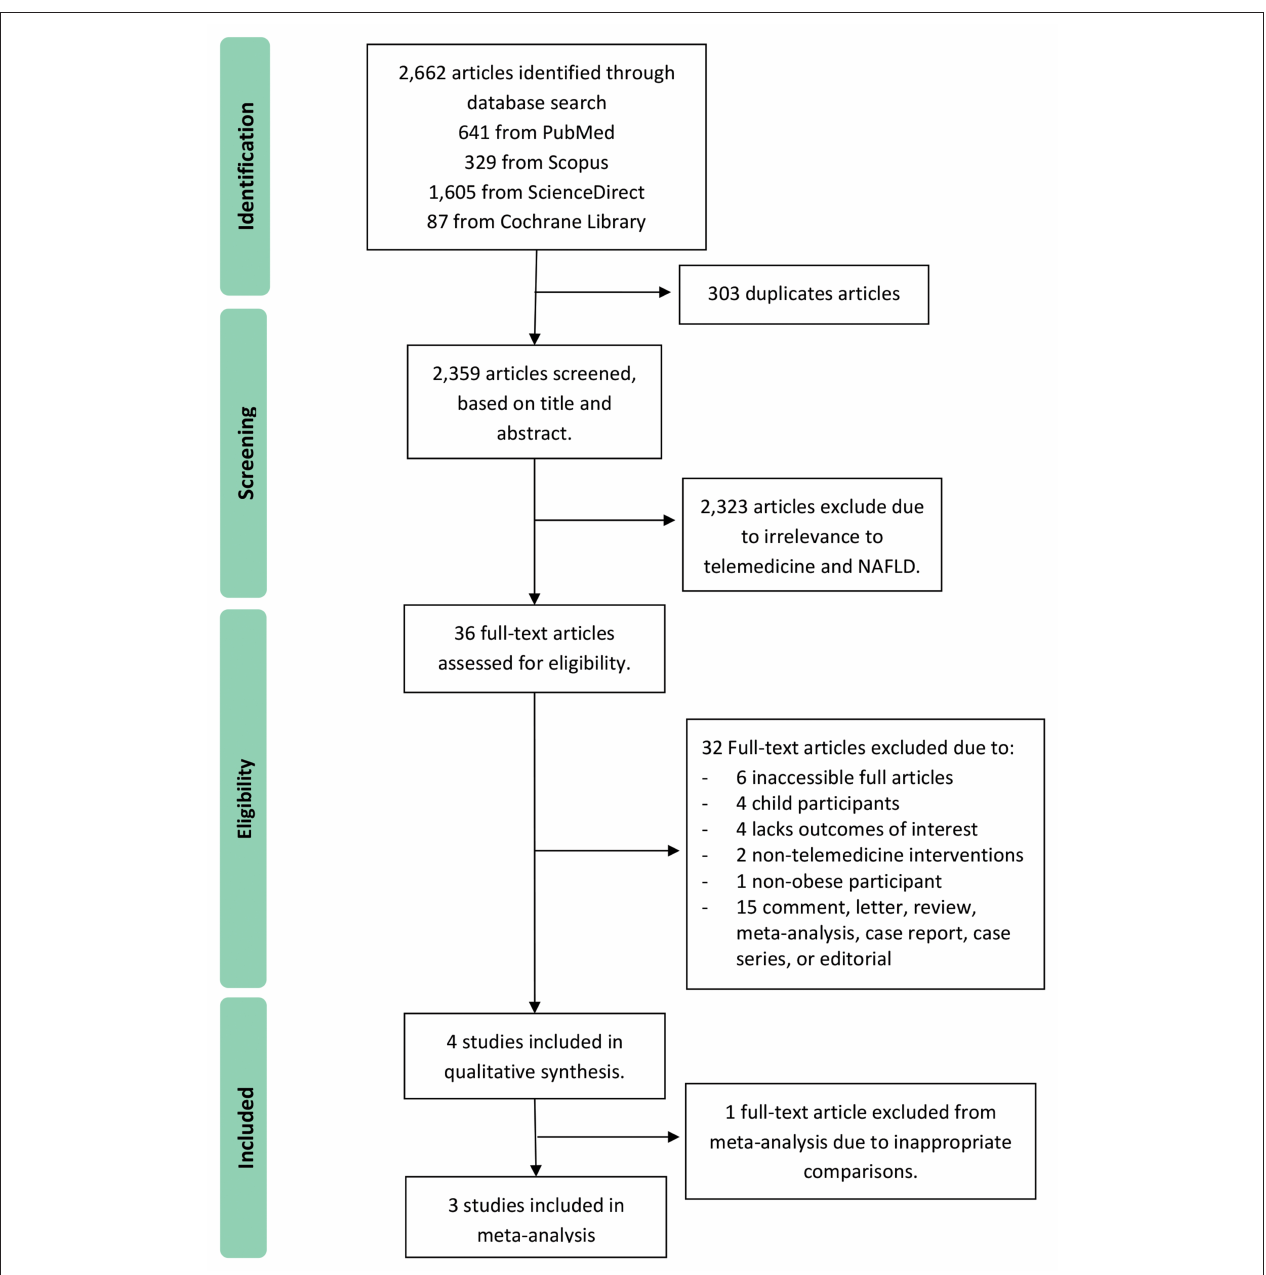
FIGURE 1 | PRISMA flow